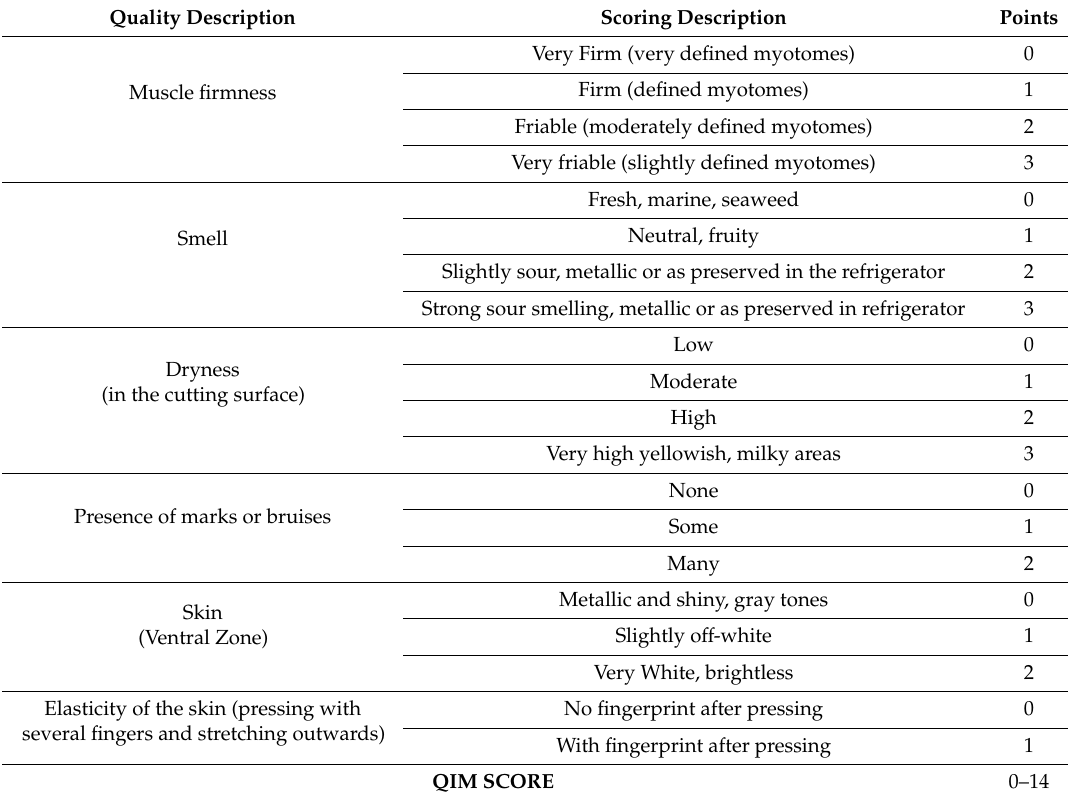
Table 1. Quality index method (QIM) attributes evaluated for hake fillets.